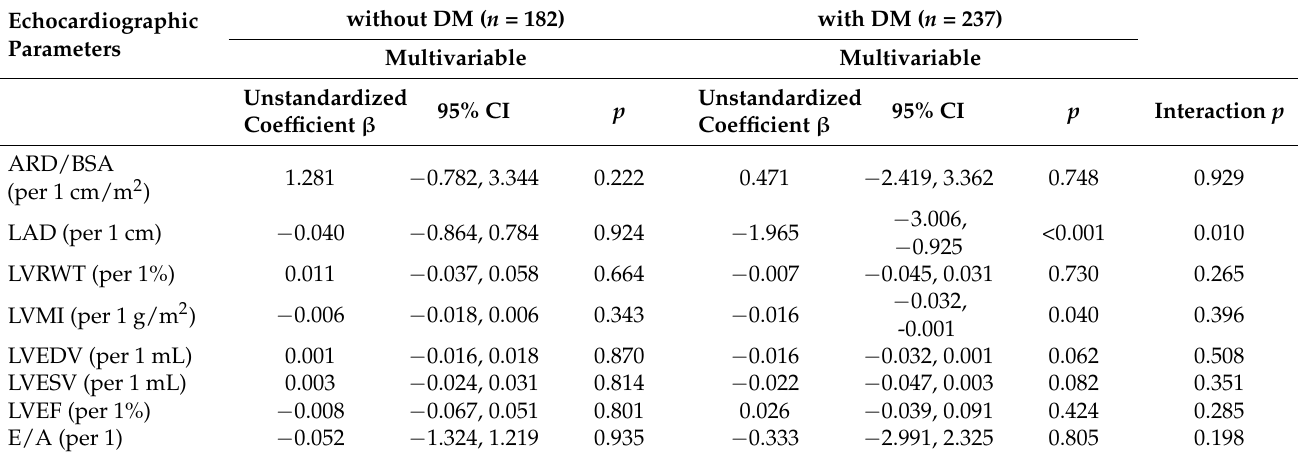
Table 4. Relation of echocardiographic parameters to eGFR slope using multivariable linear